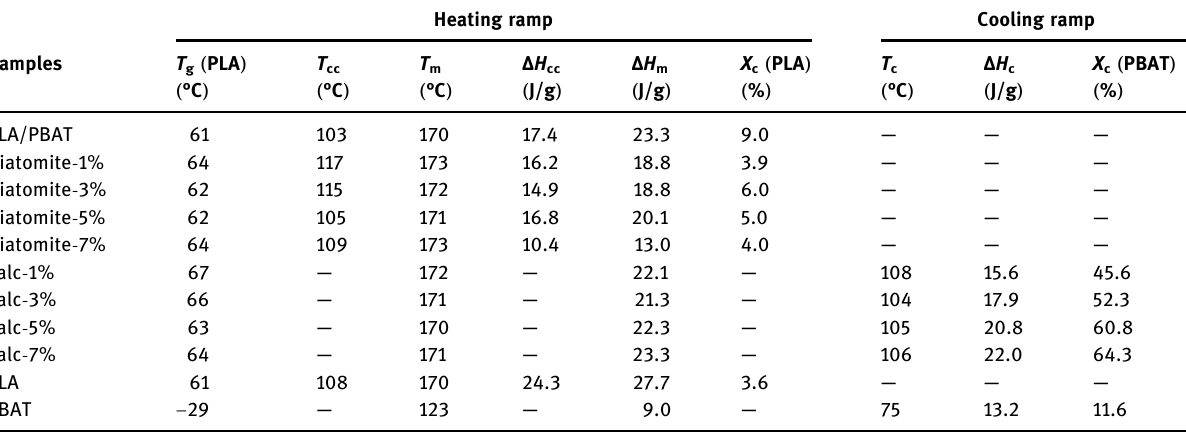
Table 1: Thermal properties of the blends tested from DSC experiments Heating ramp Cooling ramp Samples